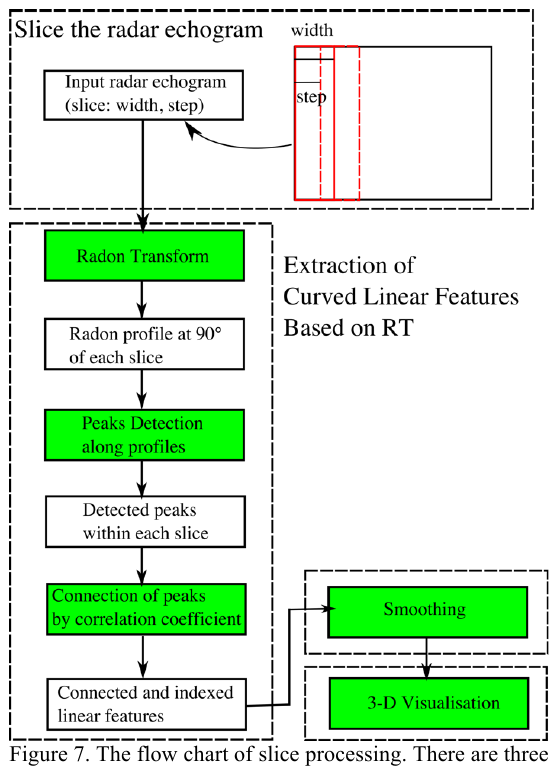
Figure 7. The flow chart of slice processing. There are three stages: A. Slice the radar echogram; B. Extraction of curved linear features based on RT, C. Smoothing and D. 3-D visualisation. (green rectangles indicate the steps, white ones denote the intermediate results).